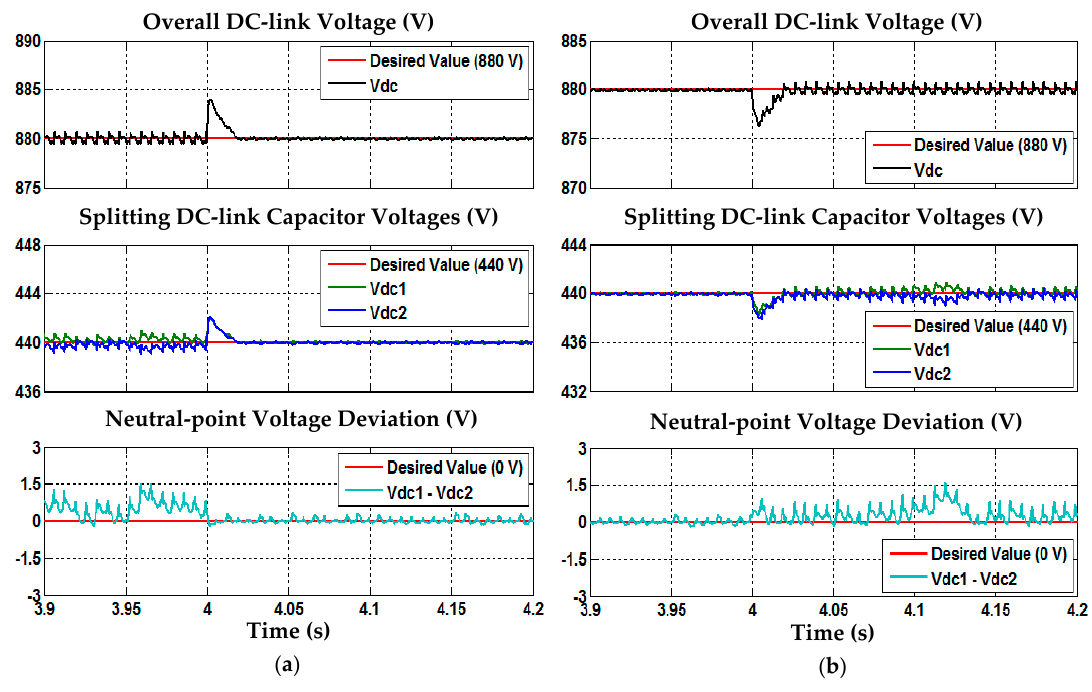
Figure 8. Simulated waveforms (case 2) of overall DC-link voltage V dc , splitting DC-link capacitor voltages V dc 1 and V dc 2 , and neutral-point voltage deviation Vd ( V dc 1 − V dc 2 ) for dynamic-state conditions of ( a ) resistive to inductive and ( b ) inductive to resistive.